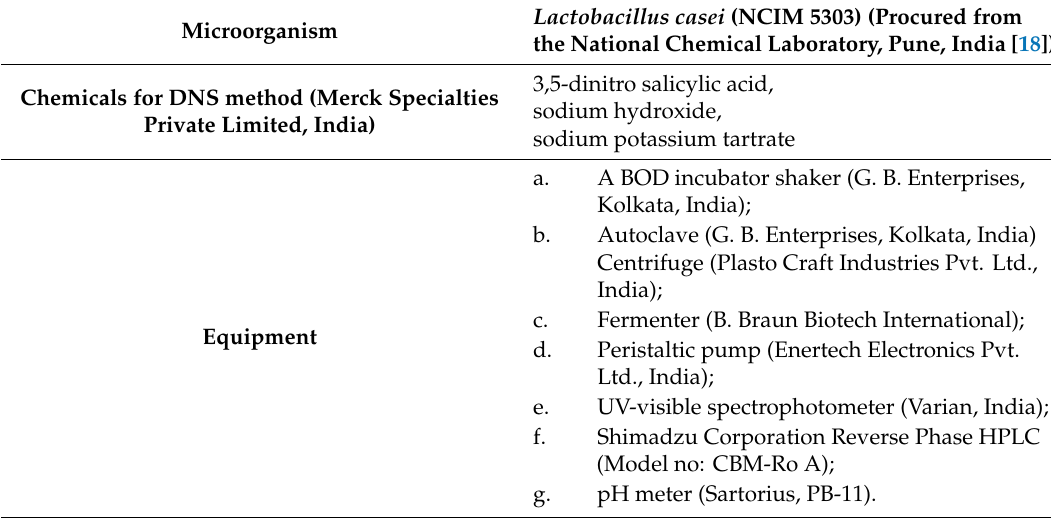
Table 1. Details of materials and equipment used for the batch study.